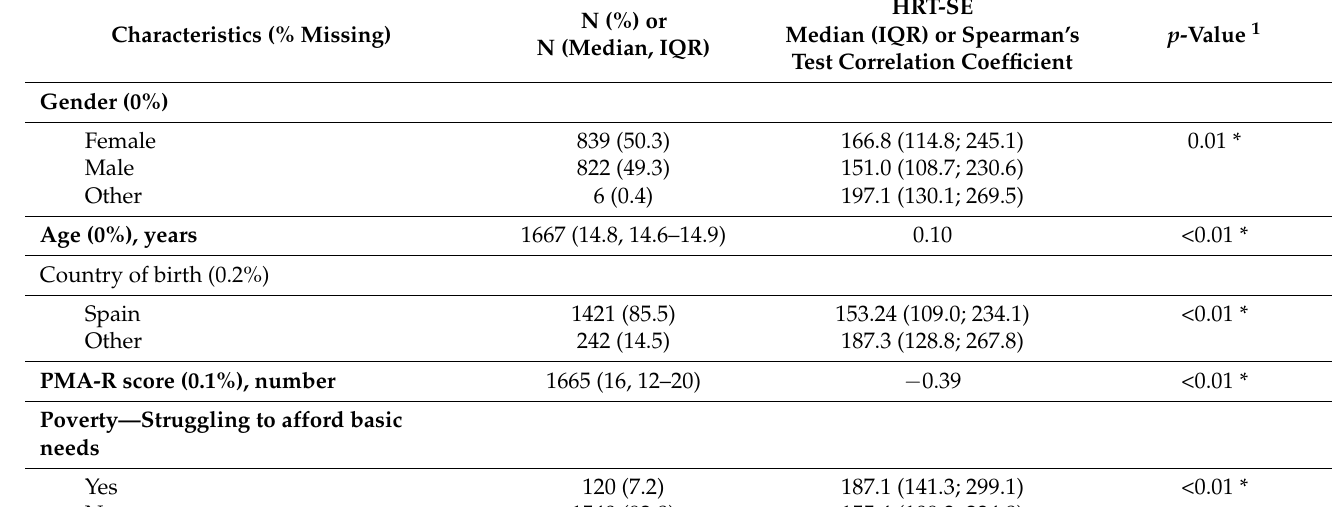
Characteristics (%